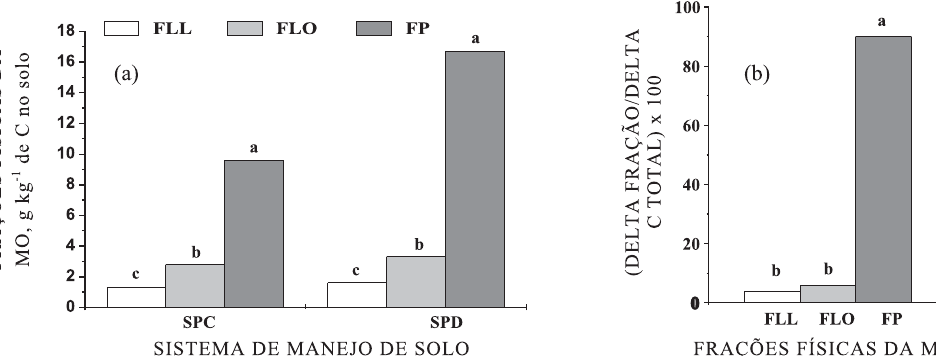
Figura 2. Estoques de C nas frações leve-livre (FLL), leve-oclusa (FLO) e pesada (FP) da matéria orgânica (MO) no solo em sistema preparo convencional (SPC) e plantio direto (SPD) (a) e proporção do C acumulado em cada fração física em relação ao total de C acumulado sob SPD em comparação ao SPC (b) na camada de 0–5 cm de um Gleissolo Háplico cultivado com arroz irrigado. Letras